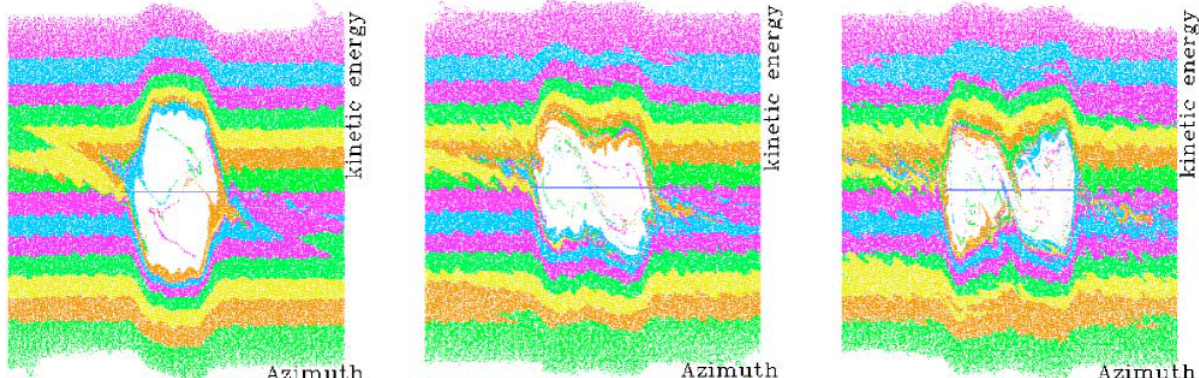
FIG. 24. (Color) Phase space scatter plots (left to right) at 2 14.39 , 2 14.09 , and 2 13.79 ms, respectively. 10 13 protons, 2.8 3 10 5 macroparticles.